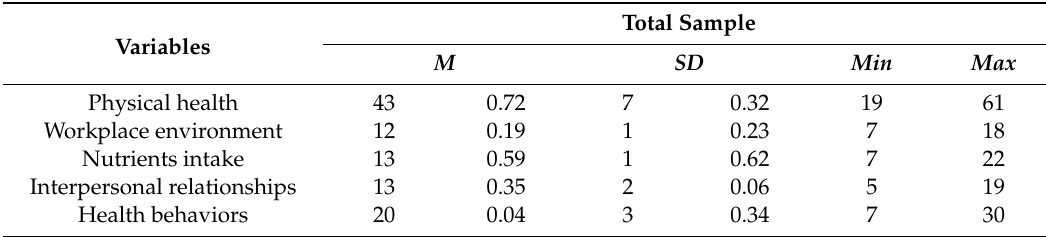
Table 1. Descriptive statistics for the study variables ( N = 571).